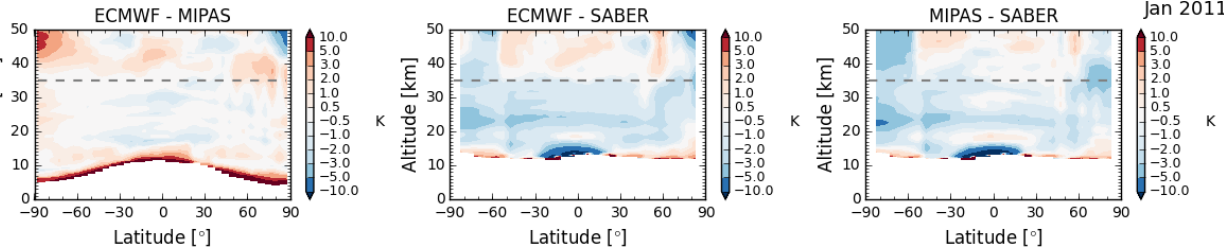
Figure 12. Dry-temperature differences between reference